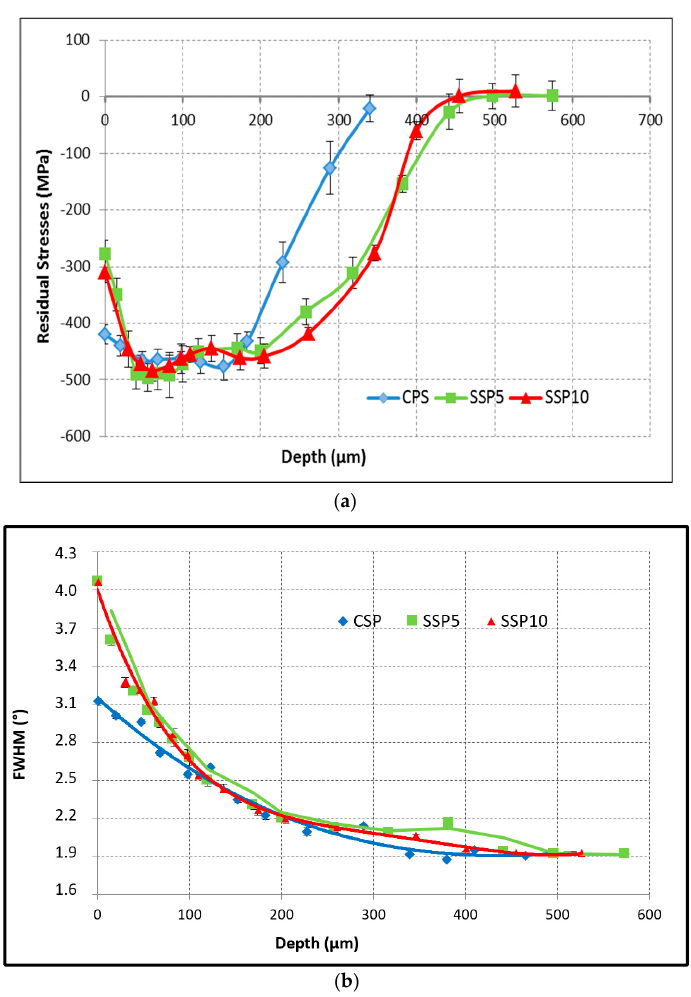
Figure 5. ( a ) Residual stress and ( b ) Full Width at Half Maximum trend for CSP, SSP5, and SSP10